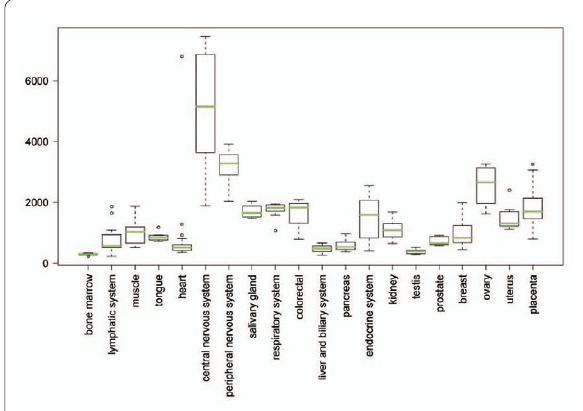
Figure 2 FMNL2 mRNA expression profile in normal human tis- sues . The normalized expression values (y-axis) of FMNL2 across nor- mal tissues (x-axis) are presented as box-plots. The box extends from the first to the third quartile of the data and the median is indicated with green. The whiskers extend to the extreme values unless there are outliers. The data observations that lie more than 1.5 * interquartile range (IQR) lower than the first quartile, or 1.5 * IQR higher than the third quartile are considered as outliers and indicated separately. High- est expression levels are seen in central and peripheral nervous sys-